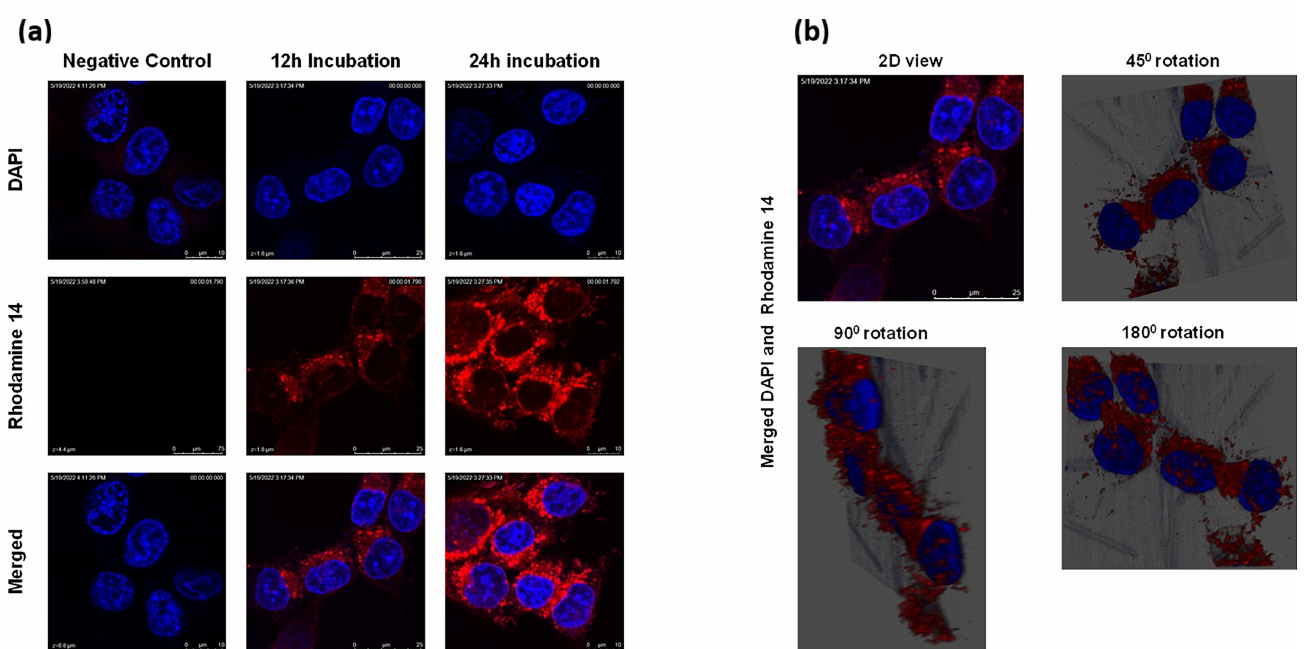
Figure 3. Cellular uptake of LnP. ( a ) 2D view of the cellular uptake of Rho-14-loaded LnP in Panc-1 cells over 12 h and 24 h with DAPI used as a nuclear stain. ( b ) 2D image of the 12 h incubation image of Rho-14, rotated to show the localization of LnP in 3D view. (See 25 s video of complete rotation in Supplementary Video S1).